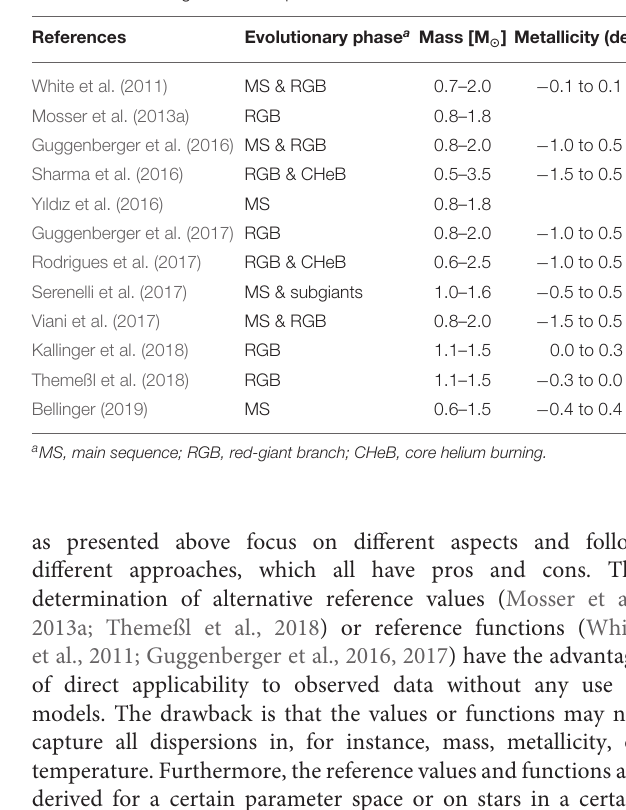
TABLE 3 | Overview of the parameter space of different corrections to the asteroseismic scaling relations as presented in the